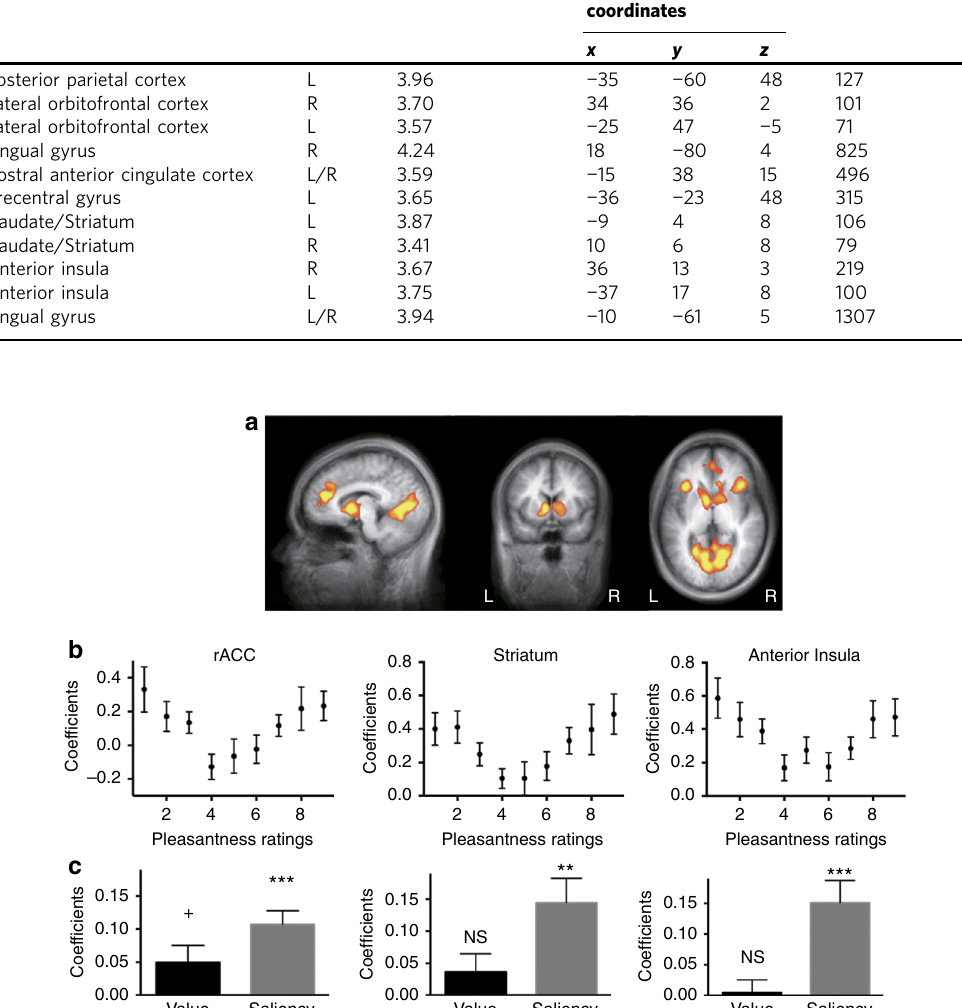
Table 1 Brain regions that showed univariate value or saliency responses (outcome expectancy) during the cue period Contrast Region